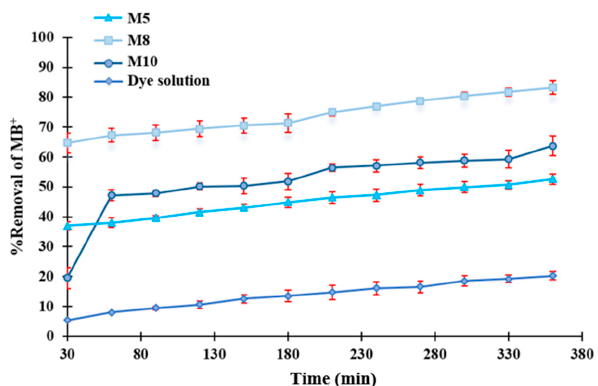
Figure 11. Dye removal using M5, M8 and M10 membranes and dye solution degradation without membrane under visible light irradiation.